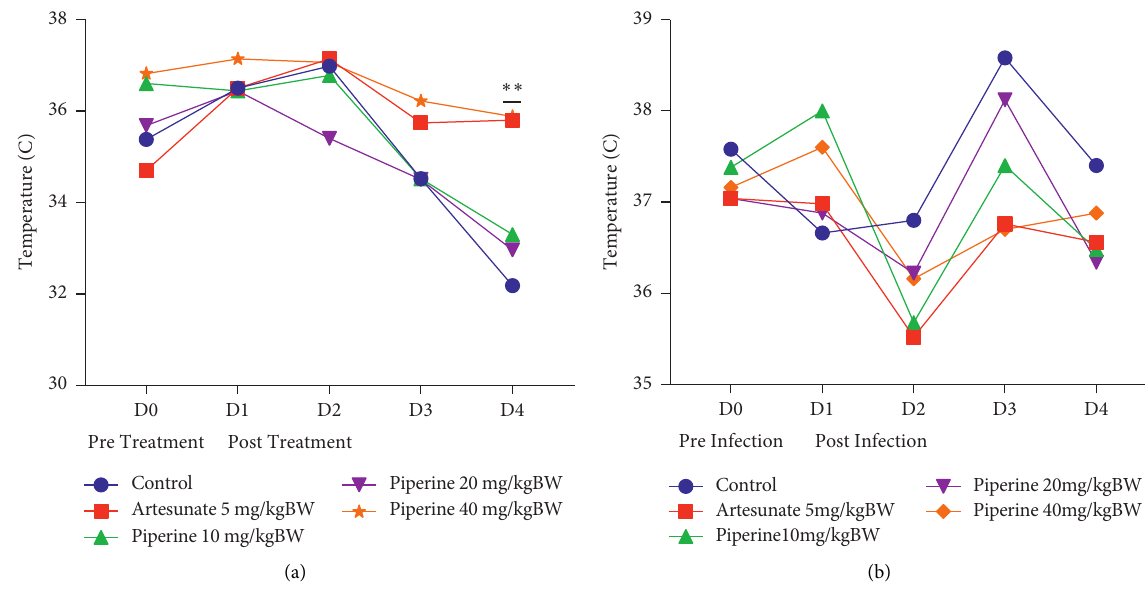
Figure 3: Effect of piperine administration on rectal temperature of mice infected with P. berghei ANKA in (a) curative test and (b) prophylactic test. Data are presented as mean ± SEM. ∗∗ p < 0 . 01 compared with negative control (two-way ANOVA followed by Tukey’s post hoc